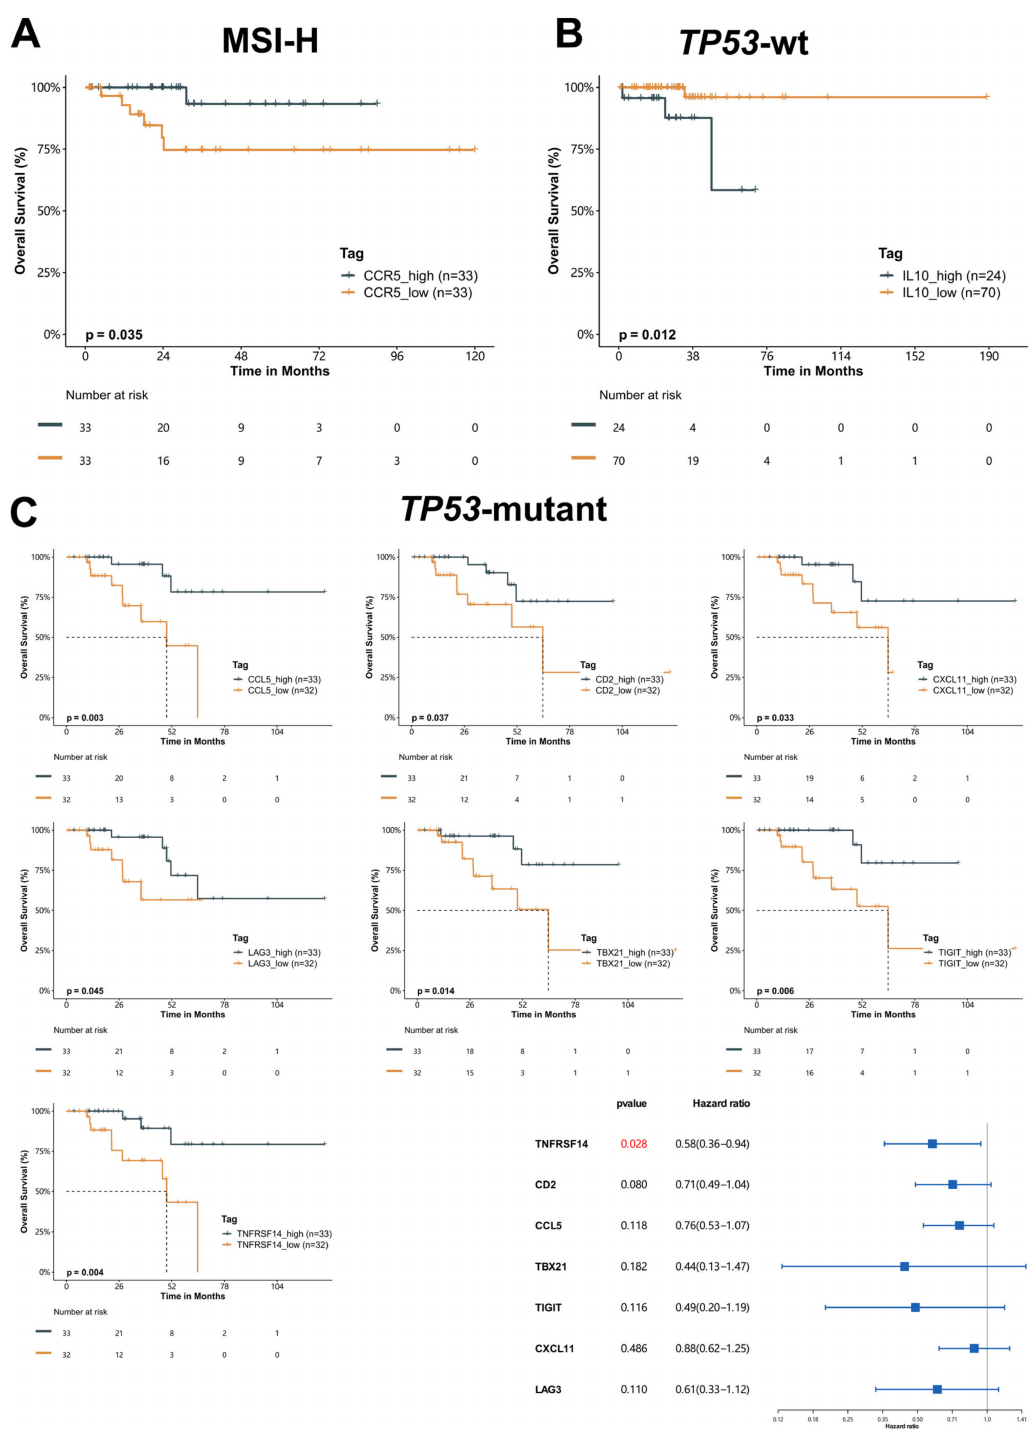
Figure 4. Survival-associated genes within molecular subtypes of endometrial cancer: ( A ) Kaplan- Meier (K-M) curve of patients with MSI-H subtype stratified by the expression of CCR5; ( B ) K-M curve of patients with TP53-wt subtype stratified by the expression of IL-10; ( C ) K-M curves of patients with TP53-mutant subtype stratified by the expression of CCR5, CD2, CXCL11, LAG3, TBX21, TNFRSF14, and TIGIT as well as forest plot illustrating the results from the multivariate Cox regression analysis. The median expression level was selected as the cut-off for all genes except for IL-10, for which the cut-off was the upper